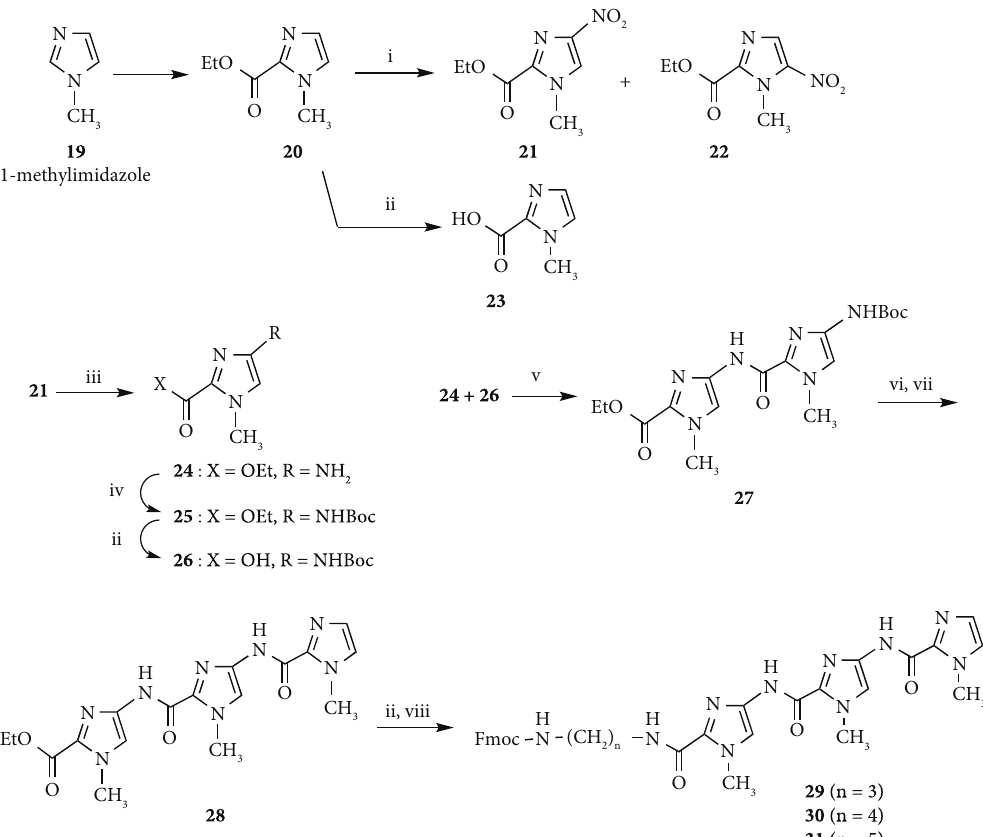
Table 2: T m values of modi Complementary